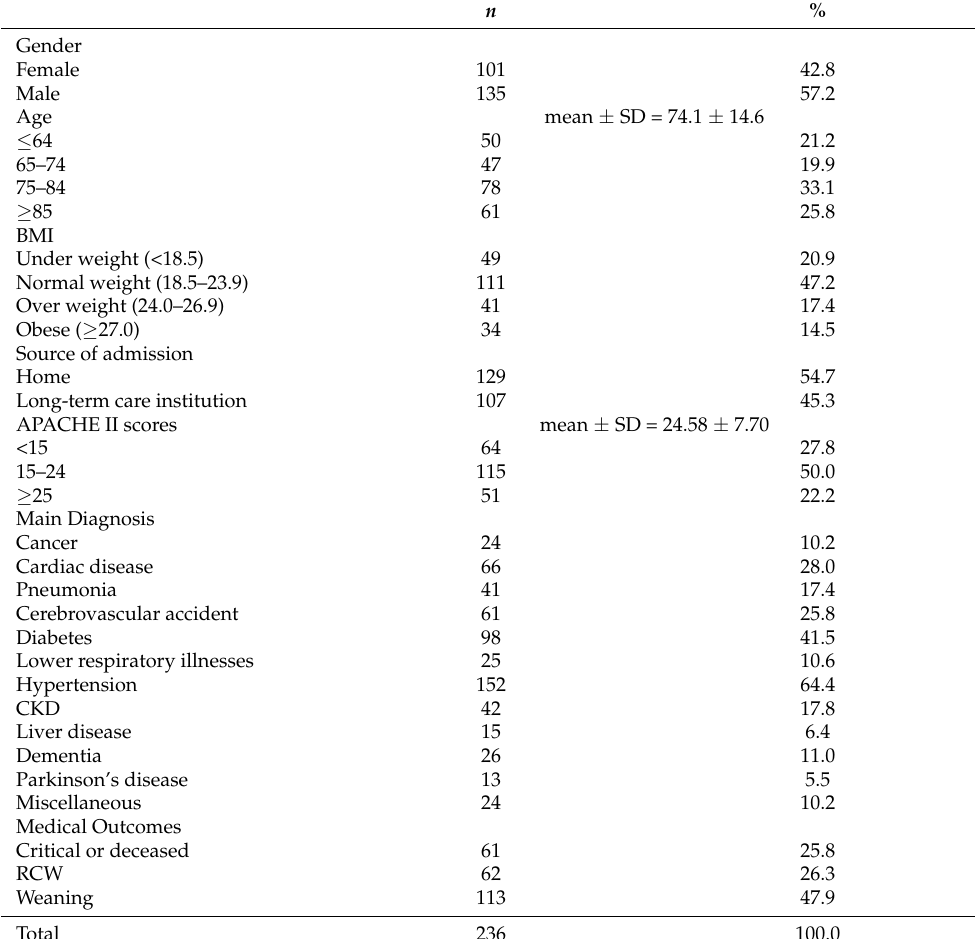
Table 1. Characters and medical results of patients in a respiratory care center (RCC).